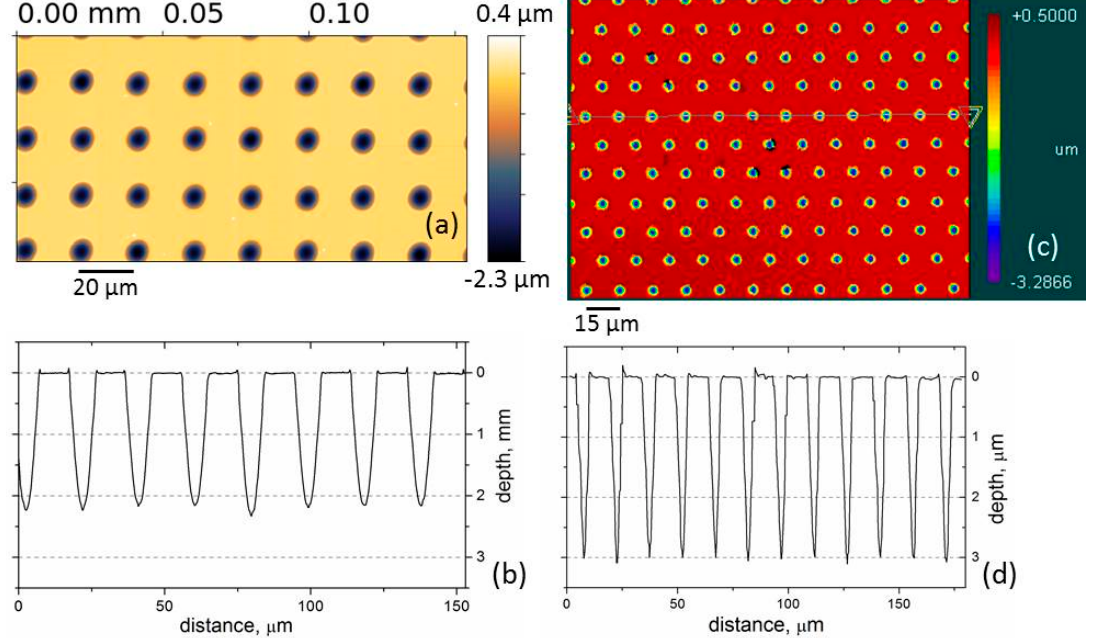
Figure 1. Femtosecond-laser produced surface micropatterns on DLN films of 3–5 μ m thickness: ( a , b ) AFM image and surface profile of a microcrater array of “square” geometry (crater diameter 10 μ m, depth 2.2 μ m, and period 20 μ m), f = 100 kHz, ε = 0.25 μ J, N = 34 pulses per crater; and ( c , d ) WLI image and surface profile of a microcrater array of hexagonal geometry (crater diameter 6 μ m, depth 3 μ m, and period 15 μ m), f = 500 kHz, ε = 0.2 μ J, N = 100 repetitions per line.